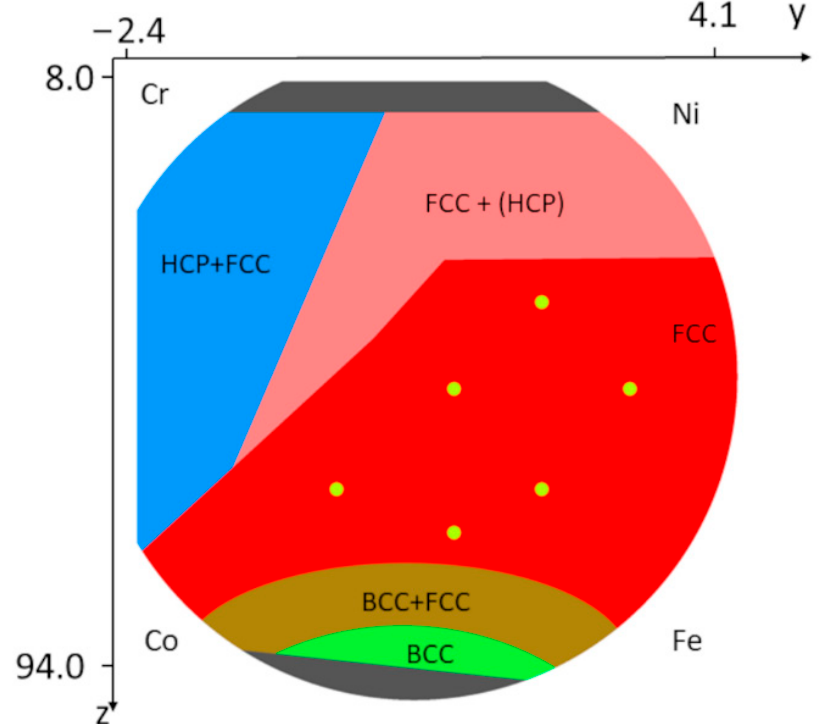
Figure 1. Phase map of the studied Co-Cr-Fe-Ni CCA film. The six small spots indicate locations where the results of the new ML-XLPA method are compared with the microstructural parameters obtained by the traditional CMWP full pattern fitting.